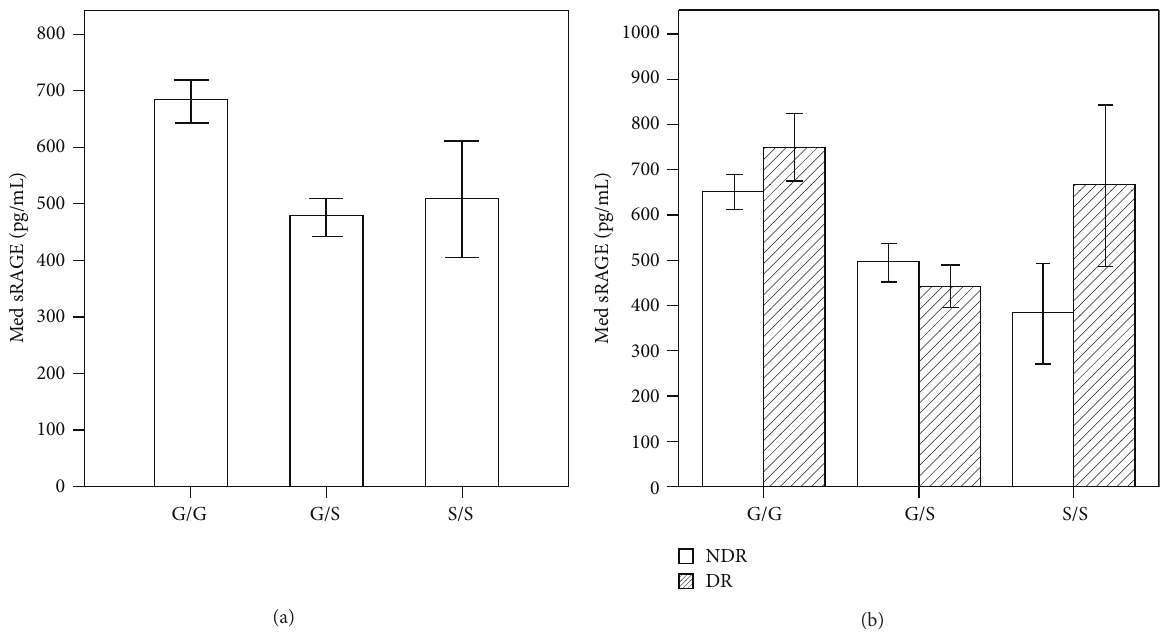
Figure 2: Influence of RAGE G82S genotypes on sRAGE. All diabetic subjects with the G/G genotype had significantly higher sRAGE concentrations than those with G/S genotype and S/S genotype (bonferroni adjustment 𝑃 < 0.01 , (a)). sRAGE concentrations in DR subjects with the S/S genotype were higher than in NDR subjects with the S/S genotype ( 𝑃 < 0.05 ). DR subjects with the G/S genotype had lower sRAGE levels than DR subjects with the G/G and S/S genotypes after adjusting for the duration of diabetes, FPG, 2hPG, LDL, and HbA1c (Bonferroni adjustment 𝑃 < 0.01 ). Note: error bars: 95%